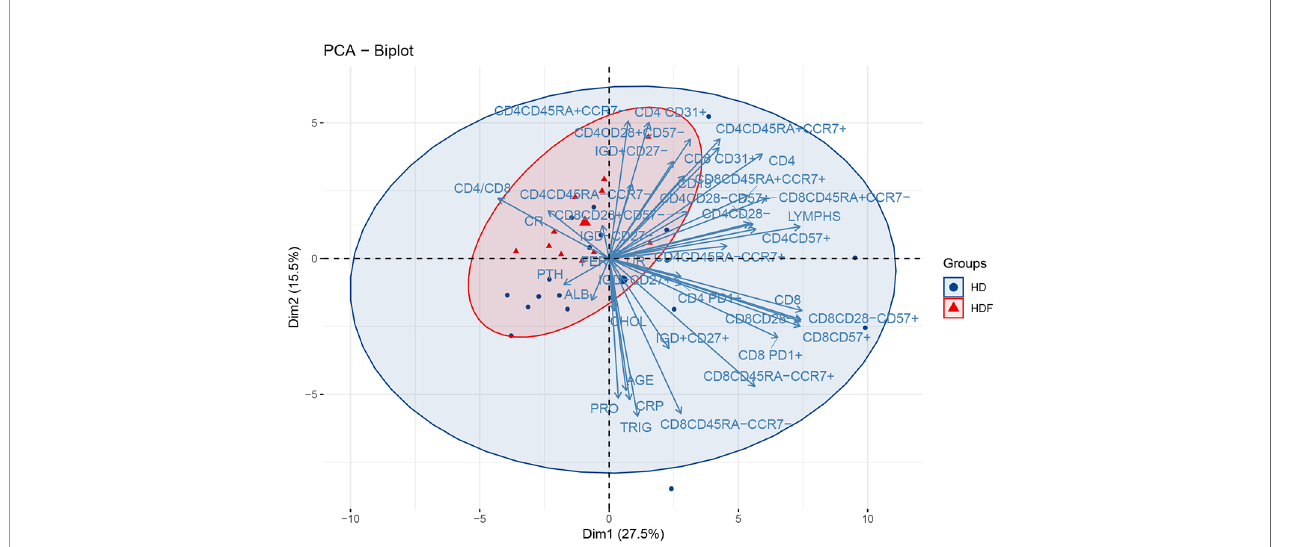
FIGURE 2 | PCA biplot of immune senescence markers and biochemical parameters of ESRD patients, on a plane de fi ned by the fi rst two eigenvectors of the covariance matrix. The loadings represent the corresponding variables. Triangles represent HDF and circles HD patients. Large symbols depict the centroid of each population and ellipses represent gaussian kernel density estimates for each